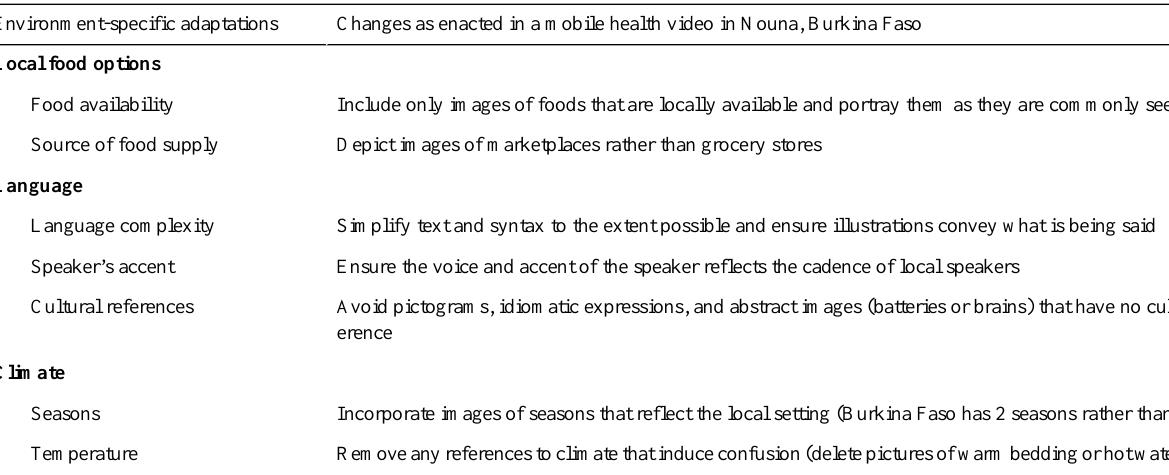
Table 8. Video adaptations: